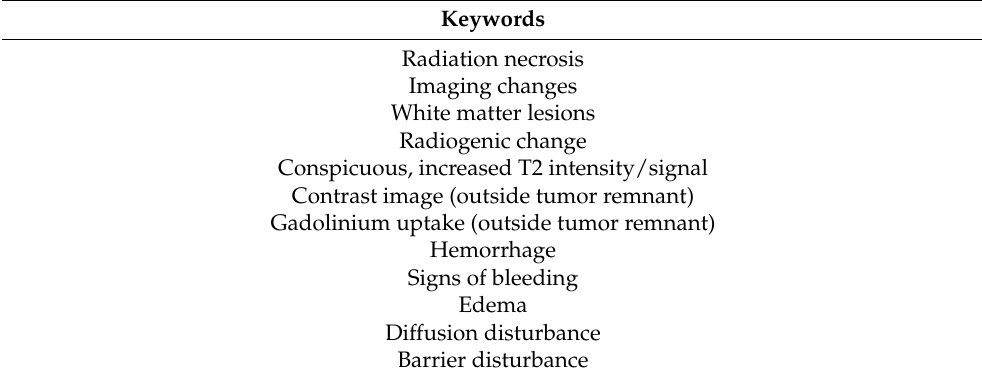
Table 1. Keywords for the screening of written reports to analyze imaging